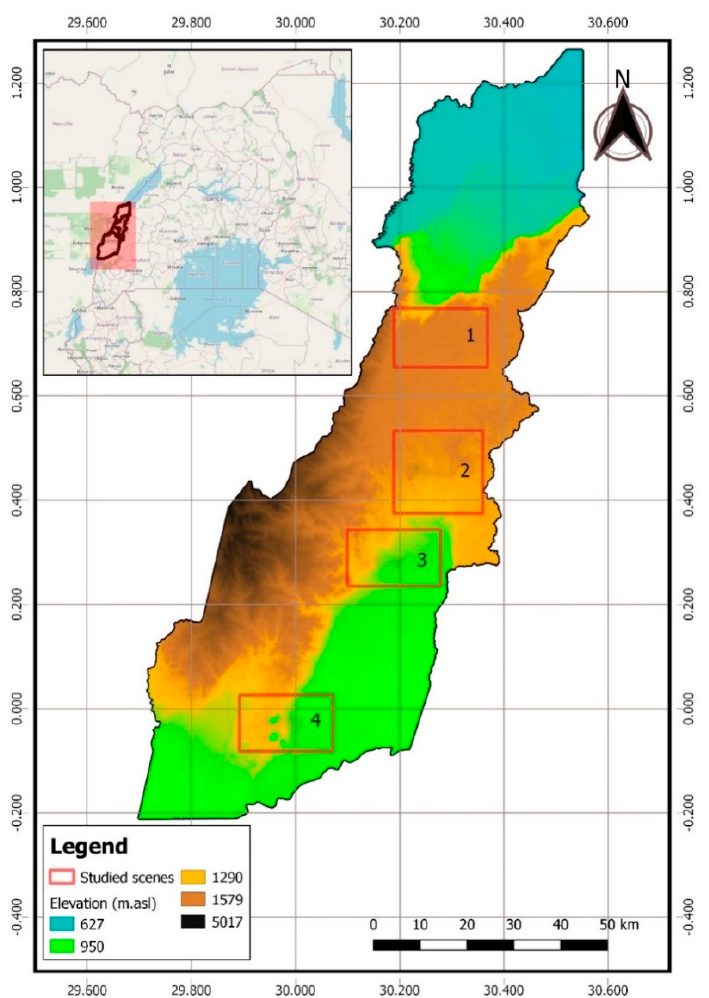
Figure 2. Map of the Rwenzori region of Uganda along with the elevation range. The red rectangles represent the studied sites (1, 2, 3, and 4).